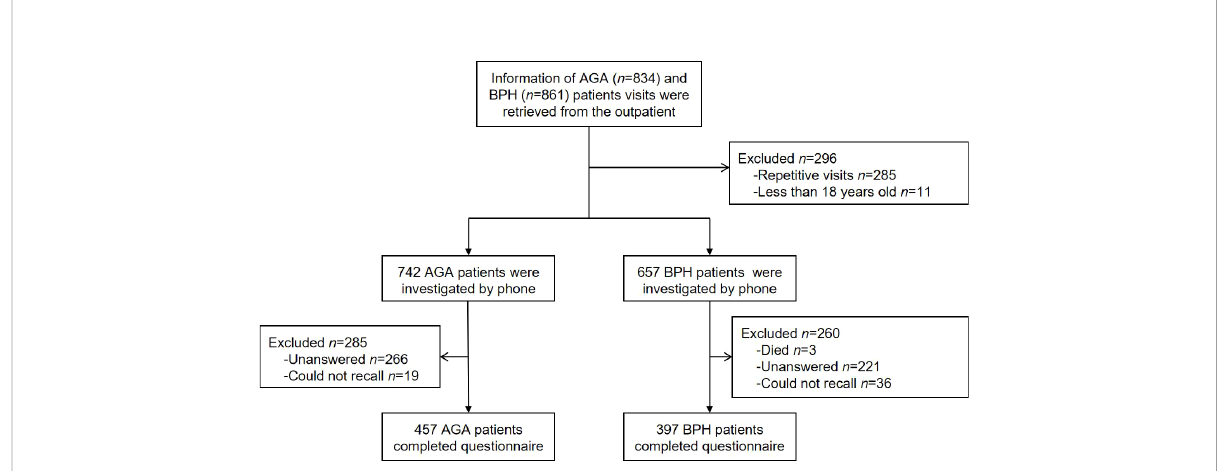
FIGURE 1 Flow diagram showing the AGA and BPH patients enrolled in the study. AGA, androgenetic alopecia; BPH, benign prostatic